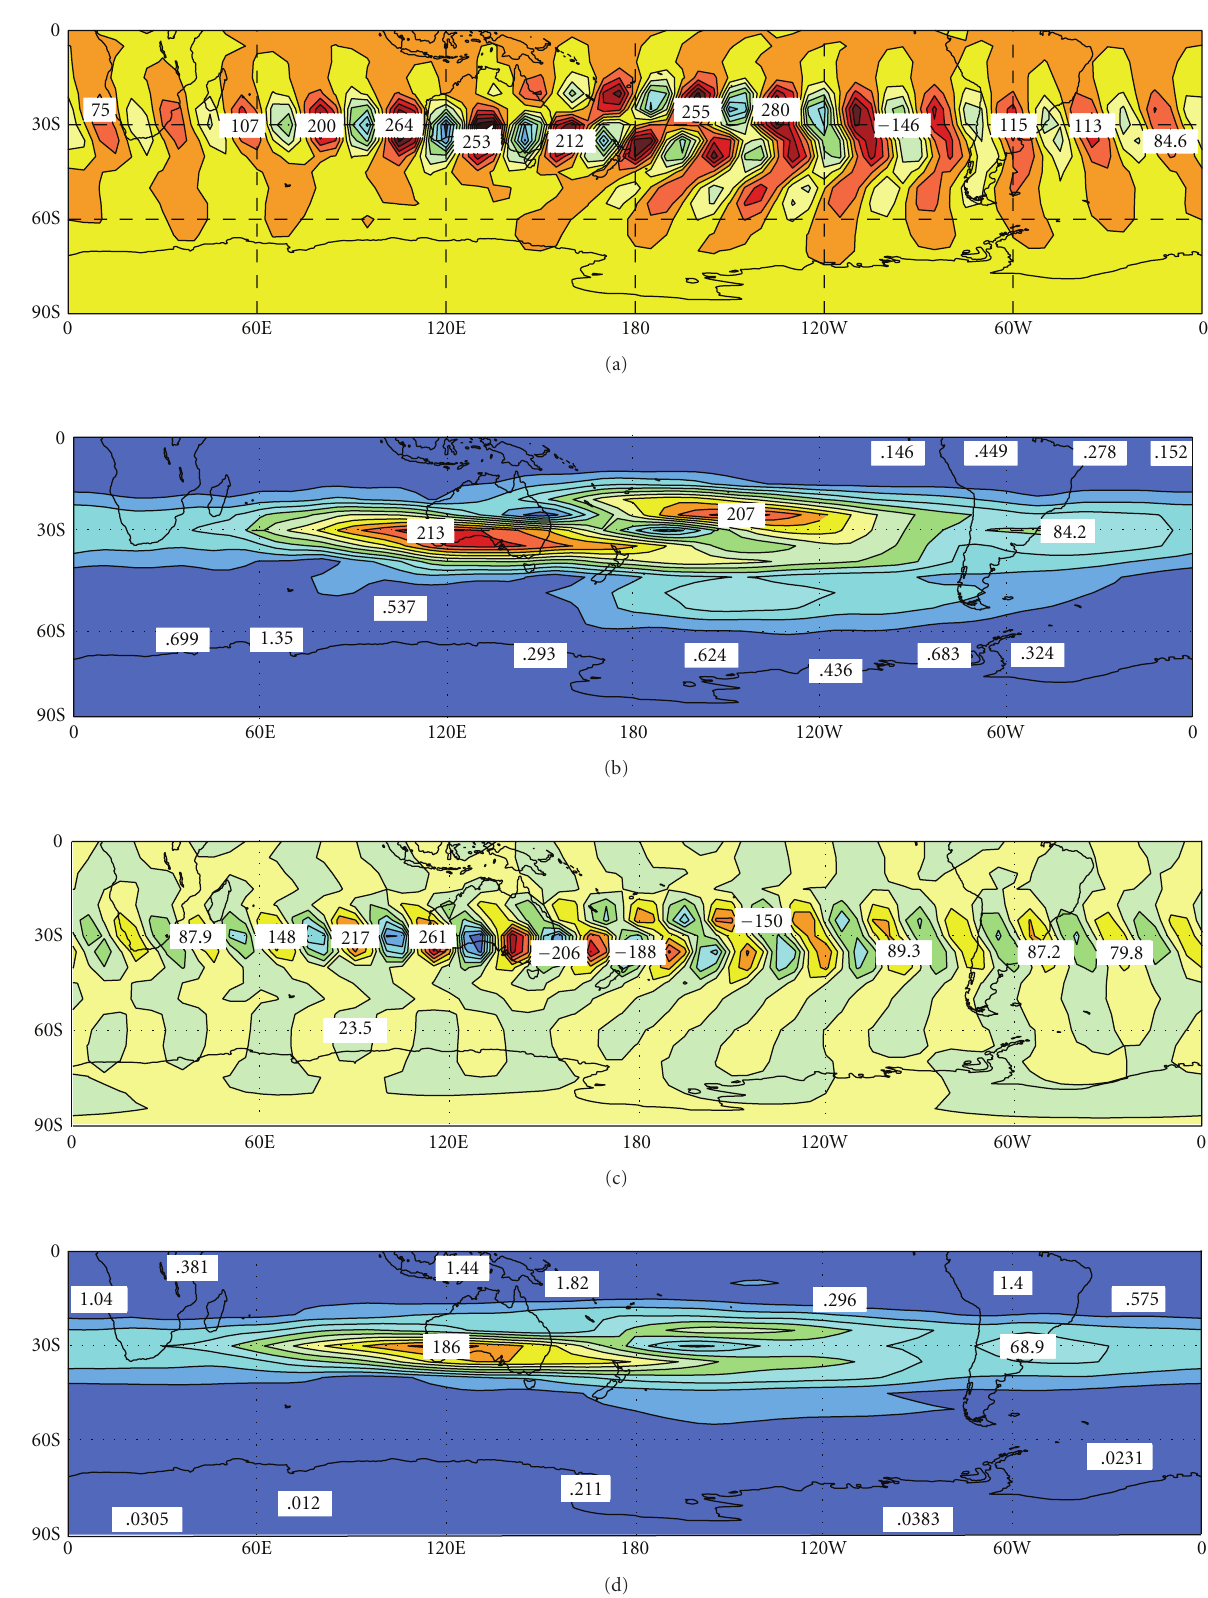
Figure 4: Shown in arbitrary units are the upper-level streamfunction (a), the RPEA of the upper-level streamfunction (b), the upper- level divergence (c), and the RPEA of the upper-level divergence (d) for mode 12, the fastest growing SH storm track mode for the July 1997–2006 basic